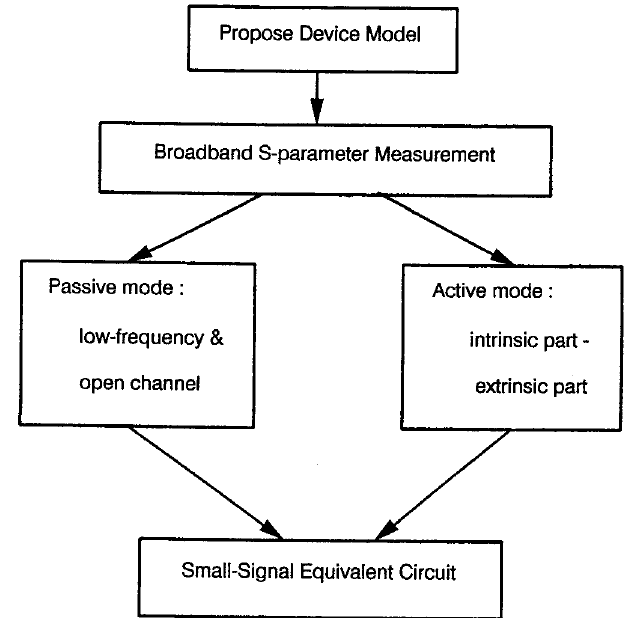
FIGURE 1 The flow chart for determining the small-signal equivalent of real space transfer